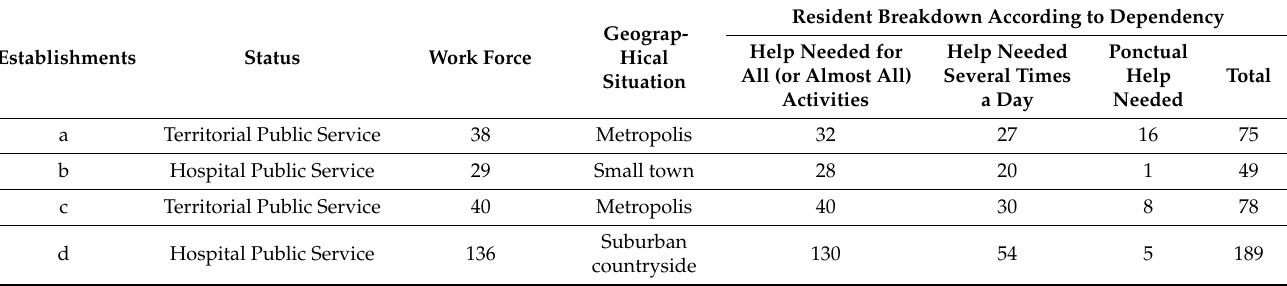
Table 1. Description of the included EHPADs according to their workforce, geographical situation, and dependency of residents.